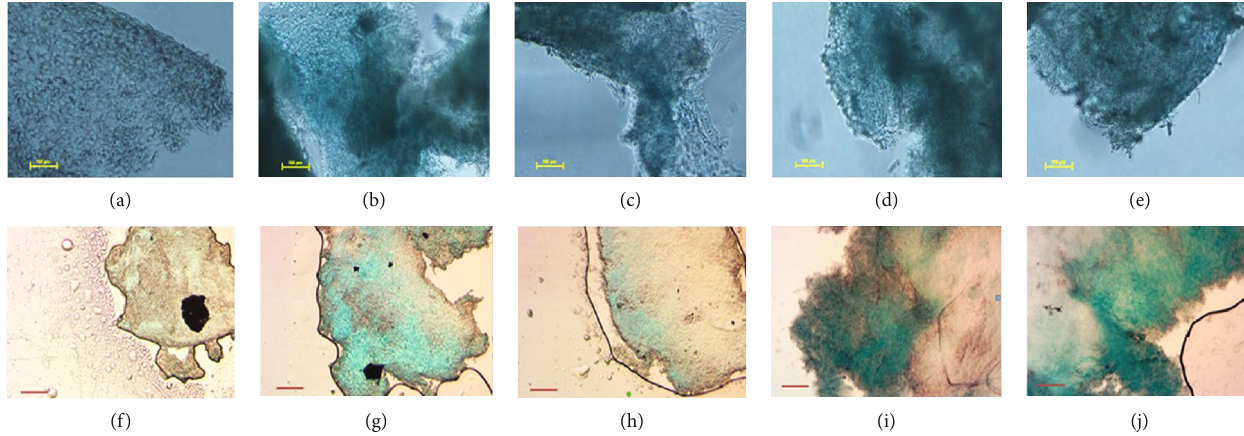
Figure 4: Chondrogenic di ff erentiation of MSCs cultured under hypoxia and normoxia. Alcian Blue staining for cells di ff erentiated for 21 days imaged in (a – e) culture wells and (f – j) on coverslips. (a) Negative control, (b) passage 5 hypoxia (P5H), (c) passage 9 hypoxia (P9H), (d) passage 5 normoxia (P5N), and (e) passage 9 normoxia (P9H). Scale bar 100 μ